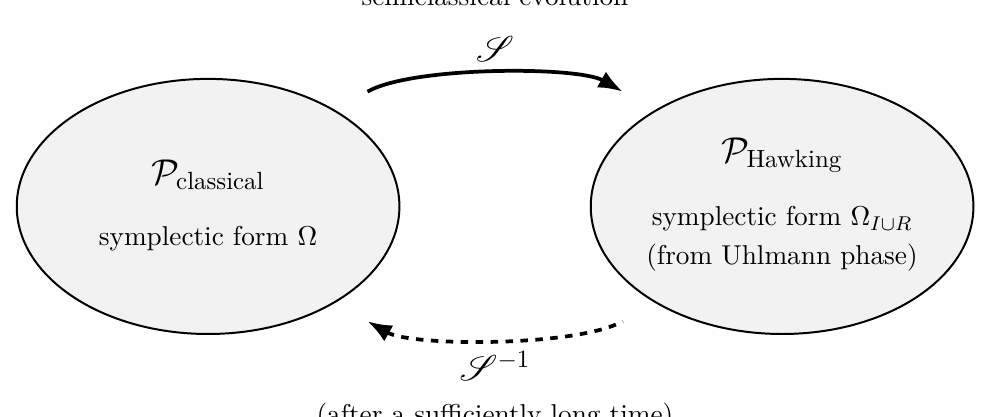
Figure 12. We reconstruct the island phase space by measuring the Uhlmann phase of the Hawking radiation. After a sufficiently long time, the map S representing the evolution between the space of classical fields and the space of Hawking radiation states becomes invertible, and all classical information is